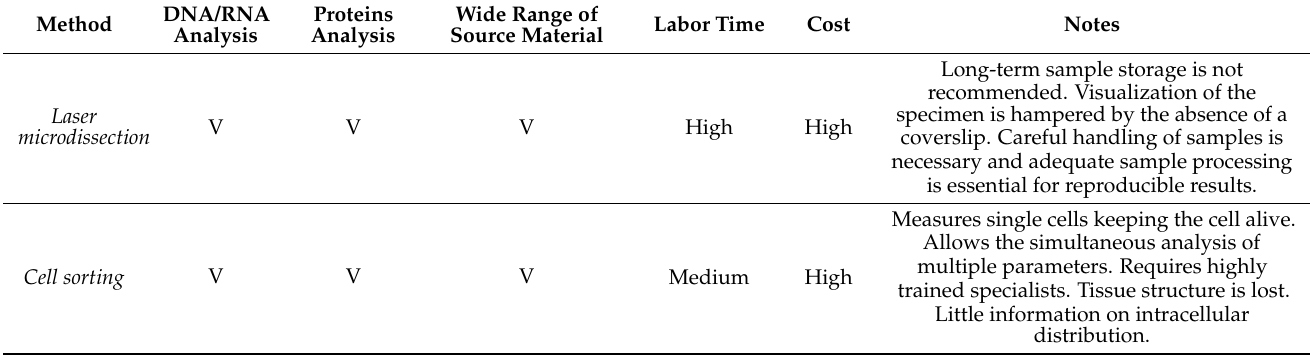
Table 1. Applications and advantages/disadvantages of cell isolation by laser microdissection and cell